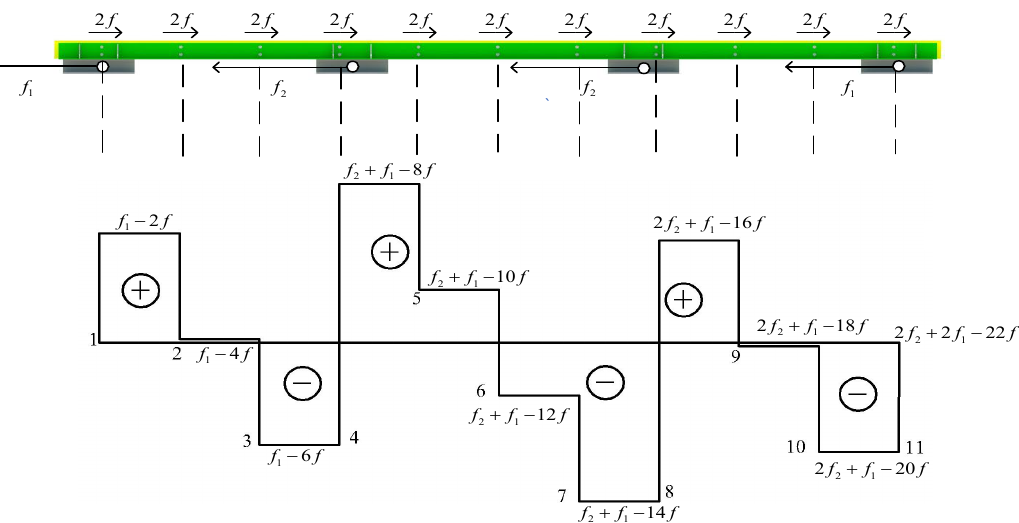
Figure 20. Axial force of the angle steel of friction energy dissipation composite chord.